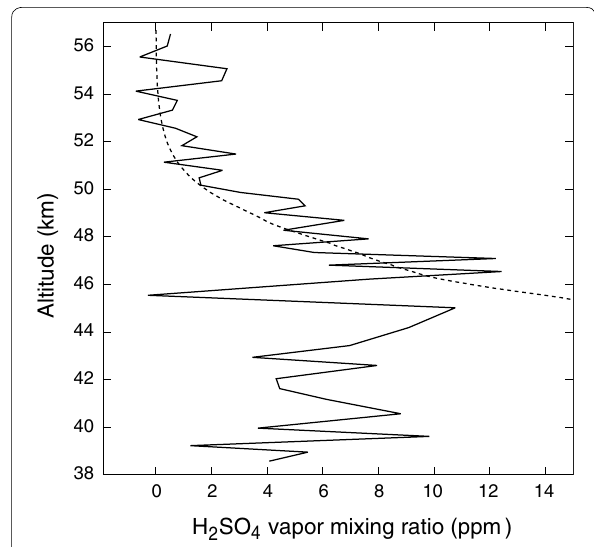
Fig. 8 An example of the H 2 SO 4 vapor mixing ratio profile obtained from the ingress occultation at 10°N conducted on May 6, 2016 (solid). The mixing ratios corresponding to the saturation vapor pres‑ sure for the observed temperature are also plotted for comparison (dotted)